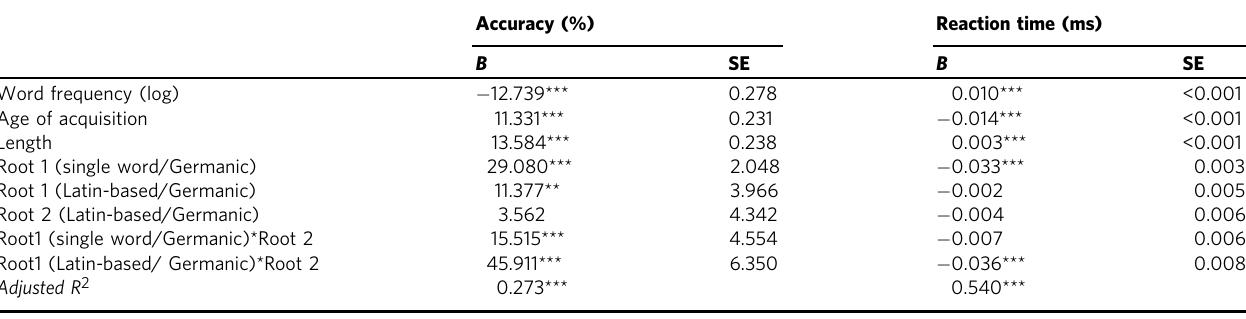
Table 2 English Lexicon Project: regression model results for naming task (accuracy and reaction time).